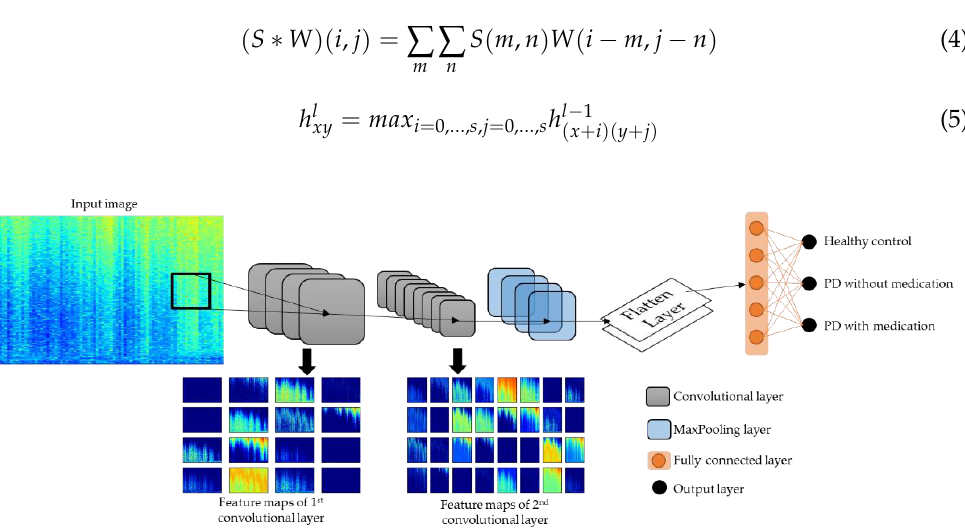
Figure 5. Model architecture of proposed 2D-CNN model. Table 4. Complete details of layer parameters of proposed 2D-CNN model.